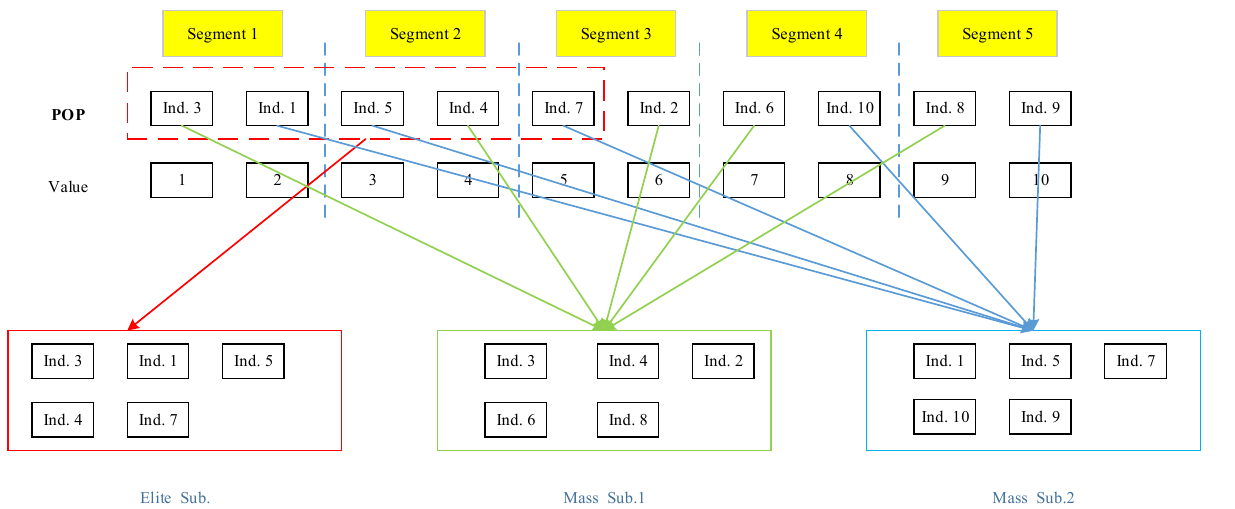
Figure 11. The process of approximate average division.